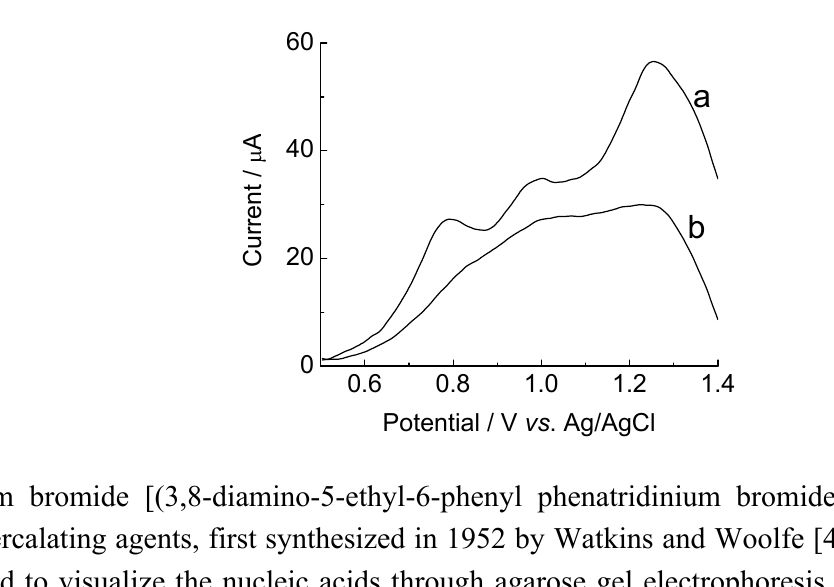
Figure 3. Differential pulse voltammograms of graphite electrode modified with poly(4-ATP) prepared in pH 0.5 (baseline-corrected), 100 scans, containing [EBV1, (oligonucleotide probe) 126 µmol·L − 1 ]: before hybridization (a) and after 20 min of incubation with complementary target (EBV2, 378 µmol·L − 1 ) (b). Electrolyte: phosphate buffer (0.10 mol·L − 1 ), pH 7.4. Modulation amplitude: 0.05 mV. Pulse interval: 0.2 s. Scan rate 5 mV·s − 1